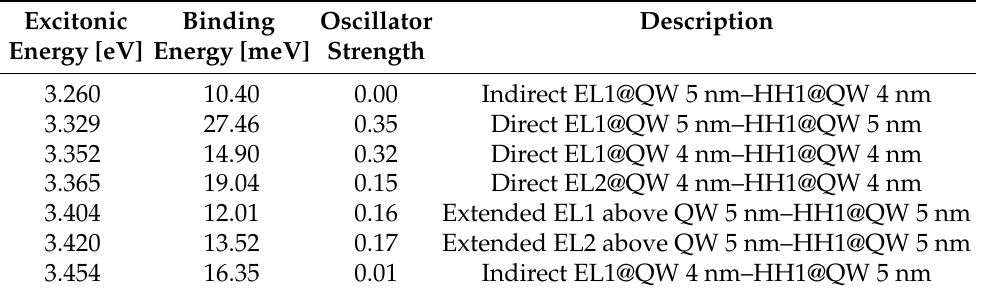
Table 4. Calculated excitonic and binding energy, oscillator strength within 8 k·p self-consistent excitonic model for various type of excitons observed in the structure